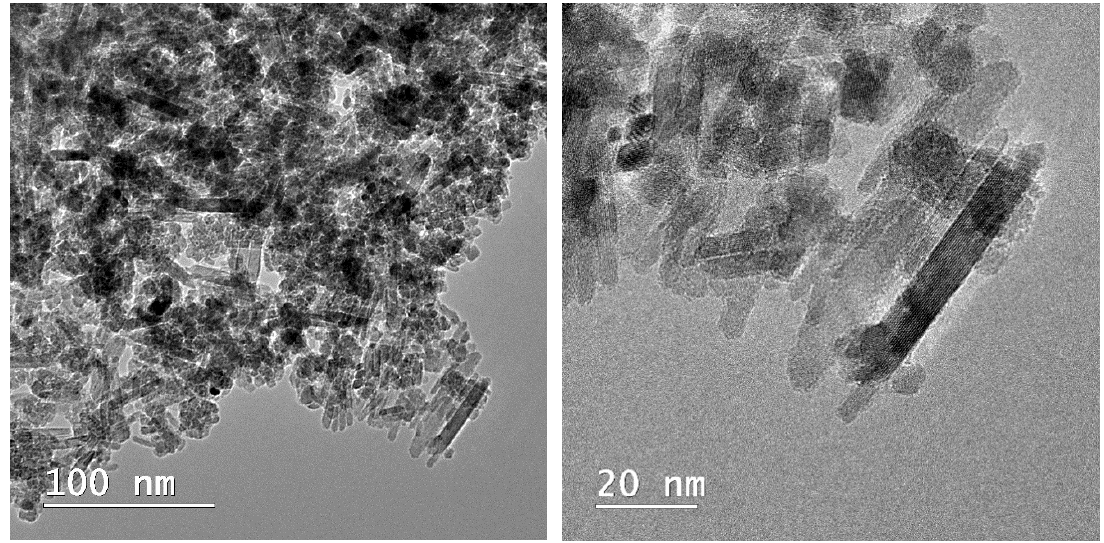
Figure 5. TEM images of the composite material (MnHAP-M), at different magnifications.